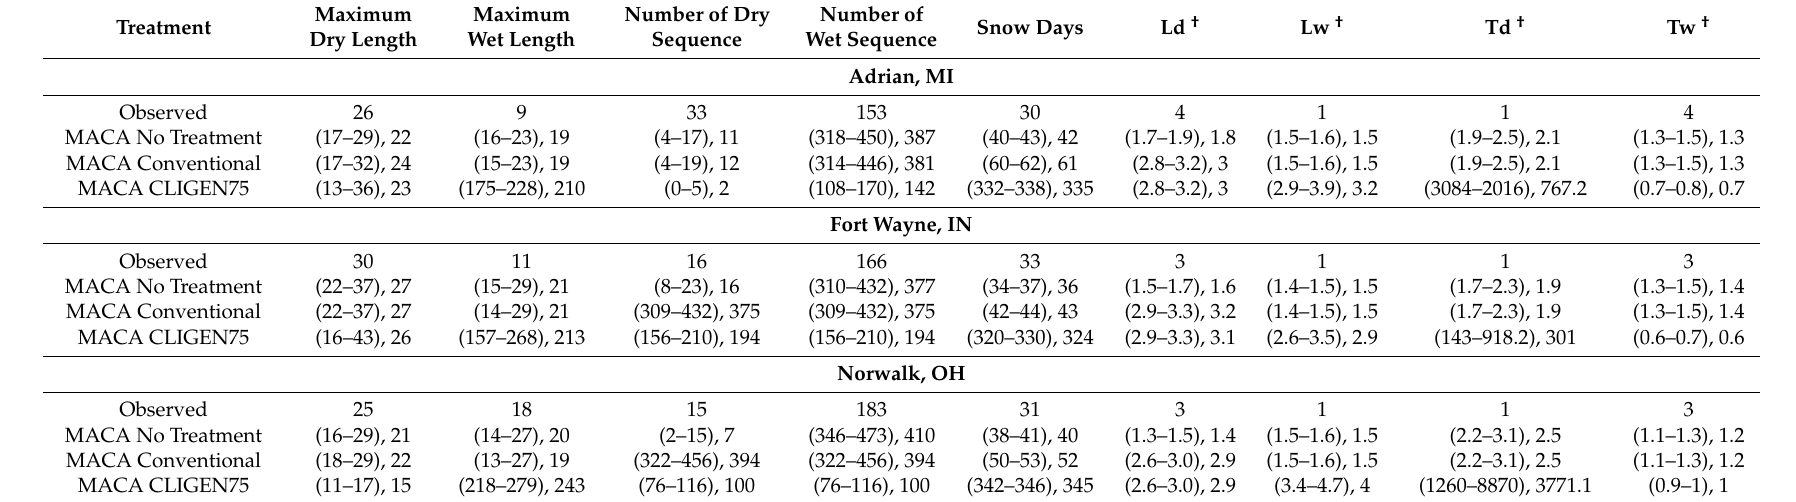
Table 5. Extreme event and general climate indices analysis for Adrian, MI; Fort Wayne, IN; and Norwalk, OH for MACA climate projections before and after different bias correction methods compared with observed climate data from ground-based